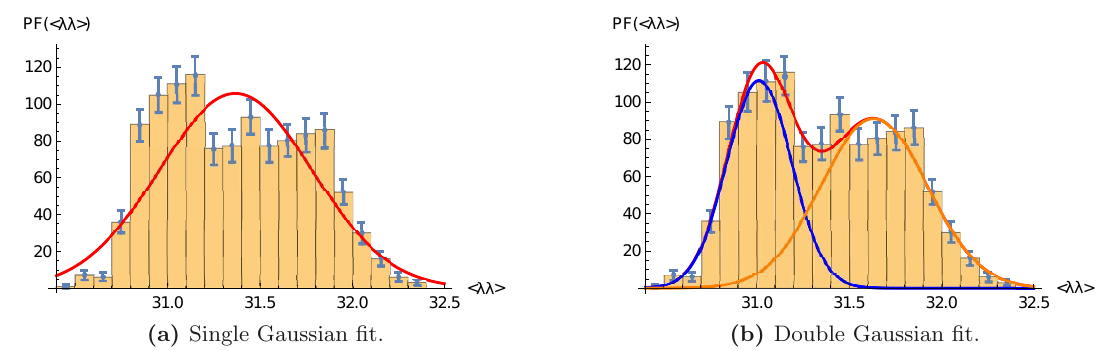
Figure 2. Double peak structure of the histogram of the chiral condensate at κ = 0 . 1665 and β = 5 . 6 from 1200 configurations. A single Gaussian does not fit our data, which are instead consistent with a sum of two Gaussian